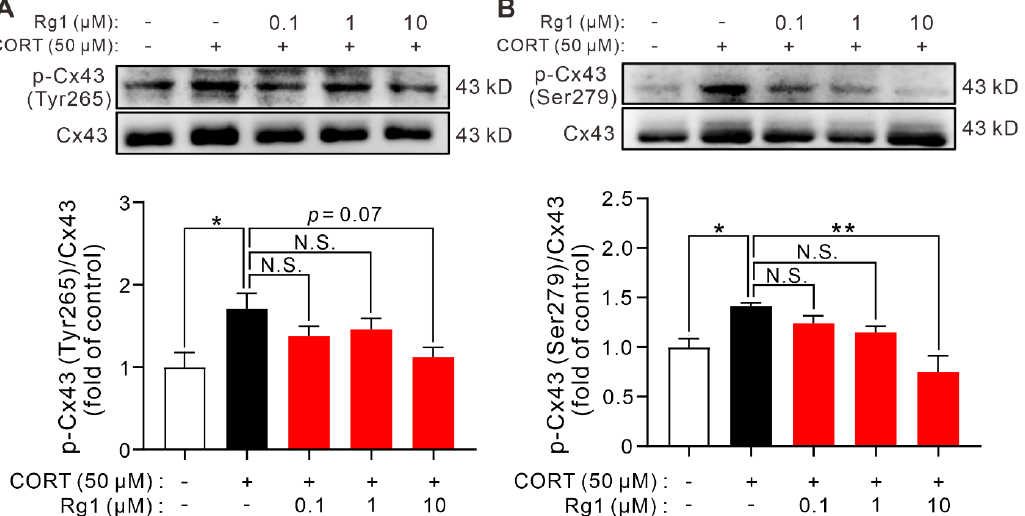
Figure 4. Rg1 inhibited the increase of phosphorylated Cx43 in astrocytes induced by CORT. ( A ) Regarding the major connexin in astrocytes, Cx43, CORT treatment increased the ratio of Tyr265- phosphorylated Cx43 to Cx43, and Rg1 (10 µM) pretreatment reversed this effect. ( B ) CORT treat- ment increased the ratio of Ser279-phosphorylated Cx43 to Cx43, and Rg1 (10 µM)